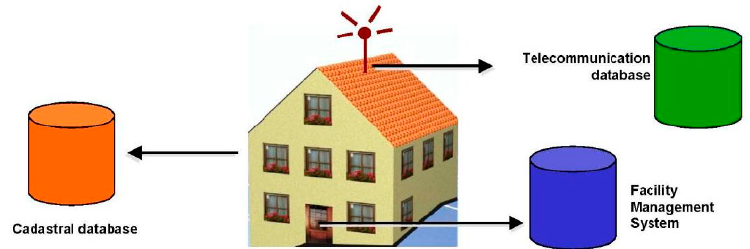
Figure 4. External references in CityGML from the CityGML 2.0 standard [15].